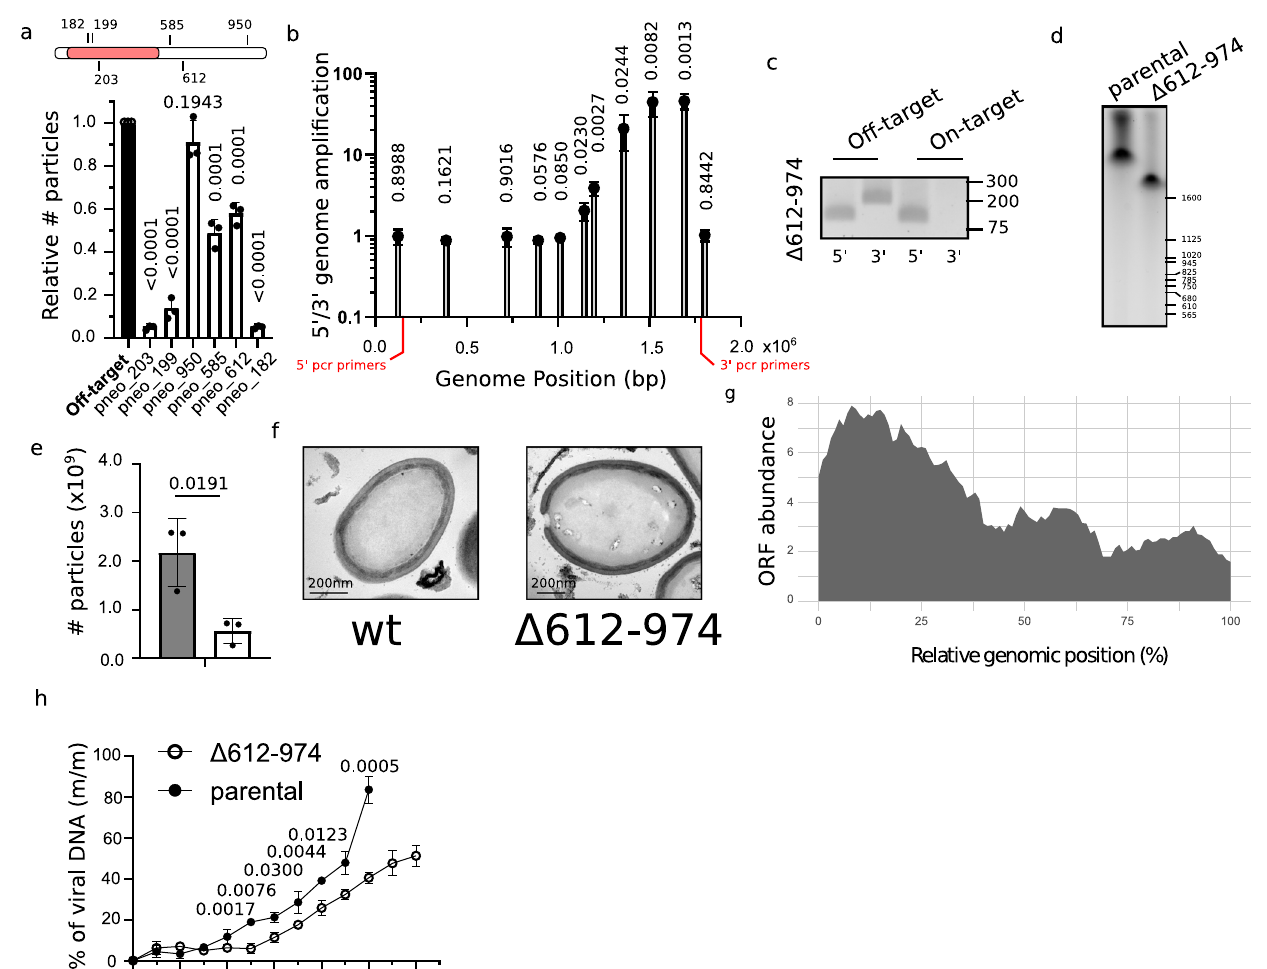
Fig. 4 | CRISPR/Cas9 targeting of pandoravirus genome demonstrates the presenceofacoreessentialgenome.a Relativequanti fi cationofthenumber(#)of viruses produced 24 hpi of CRISPR/Cas9 expressing amoebas. Data correspond to the mean±SD of 3 independent experiments. MOI=1. The essential region of the genomeishighlightedinred.Guidestargetingmollivirus mcp wereusedasoff-target gRNAs. The null hypothesis ( α = 0.05) was tested using unpaired two-tailed Stu- dent ’ s t tests. b qPCR analysis indicates the presence of virus with large deletions